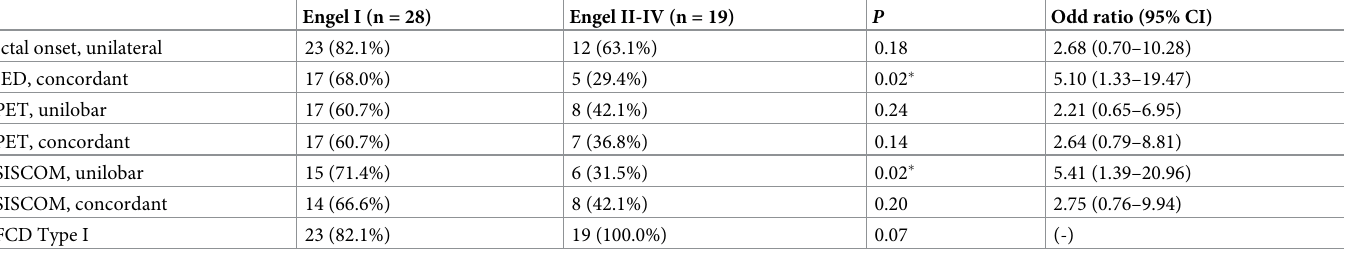
Table 3. Univariate analysis of presurgical evaluations and pathologic characteristics associated with good surgical outcomes at 2 years (Engel I) in MR-negative FCD